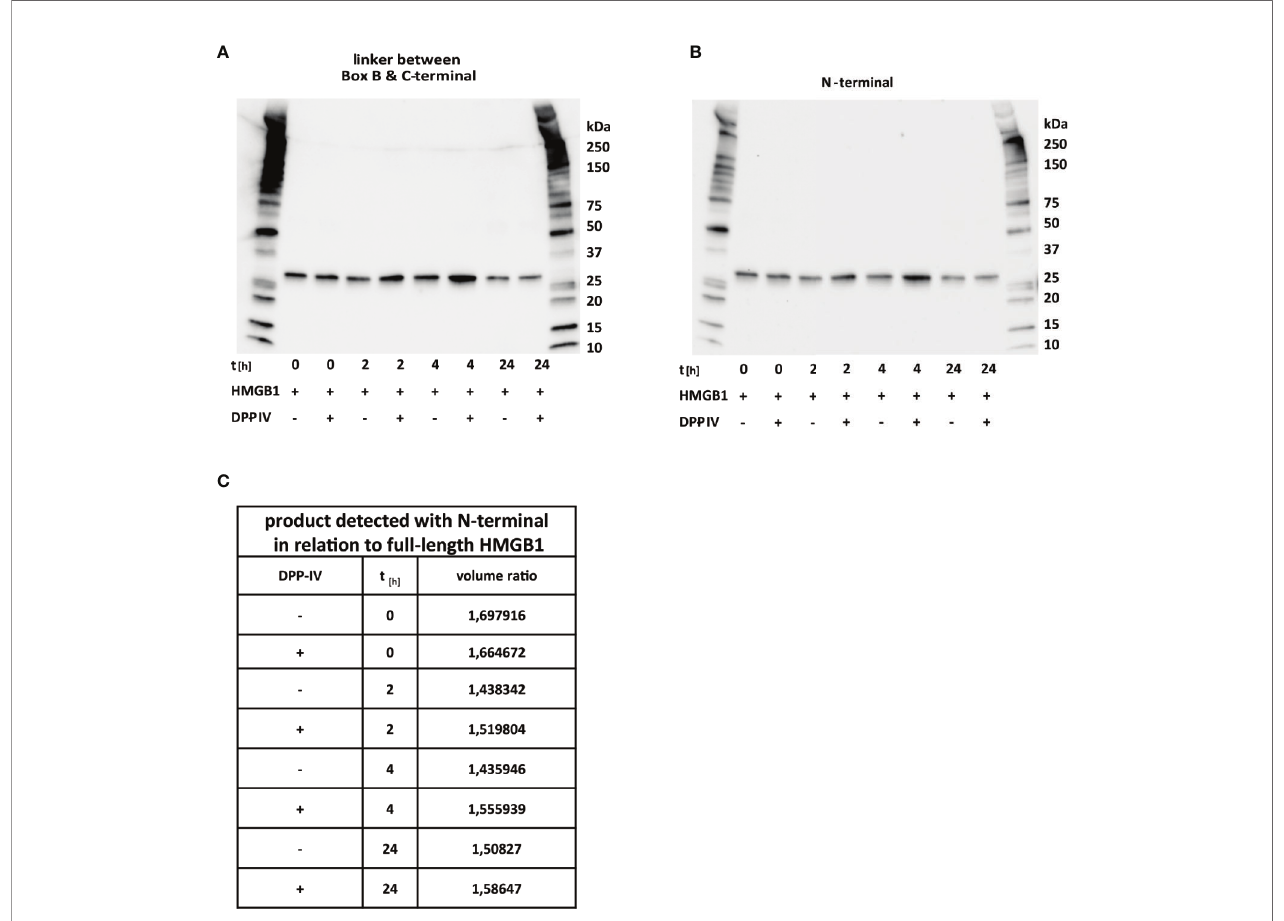
FIGURE 5 | DPP-IV does not cleave HMGB1. HMGB1 was incubated with DPP-IV up to 24 h without any detectable sign of processing occurring. (A) Western blotting with an antibody recognizing the B-to-C linker region. (B) Western blotting with an antibody recognizing the N-terminal epitope aa 2 – 17. (C) Calculated signal ratios for Western blotting results in (A, B) reveal equal signals from reactions with DPP-IV and control